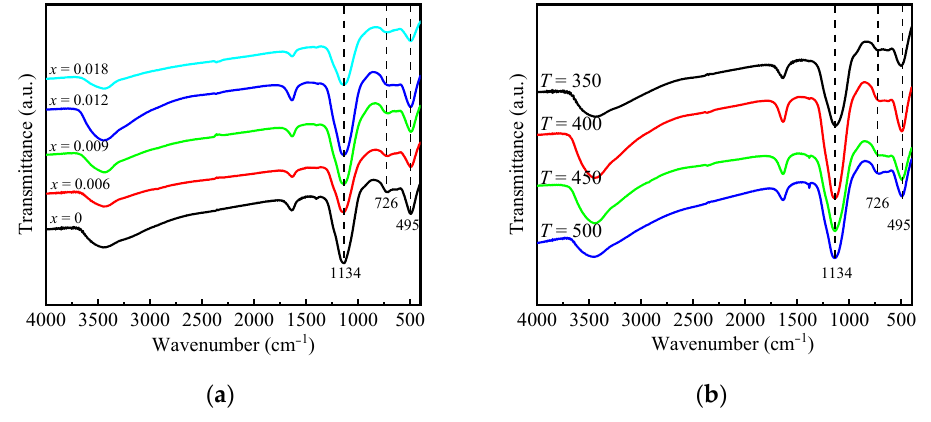
Figure 2. IR spectra of ( a ) AlP 1.1 Zr x -400 and ( b ) AlP 1.1 Zr 0.012 - T samples.